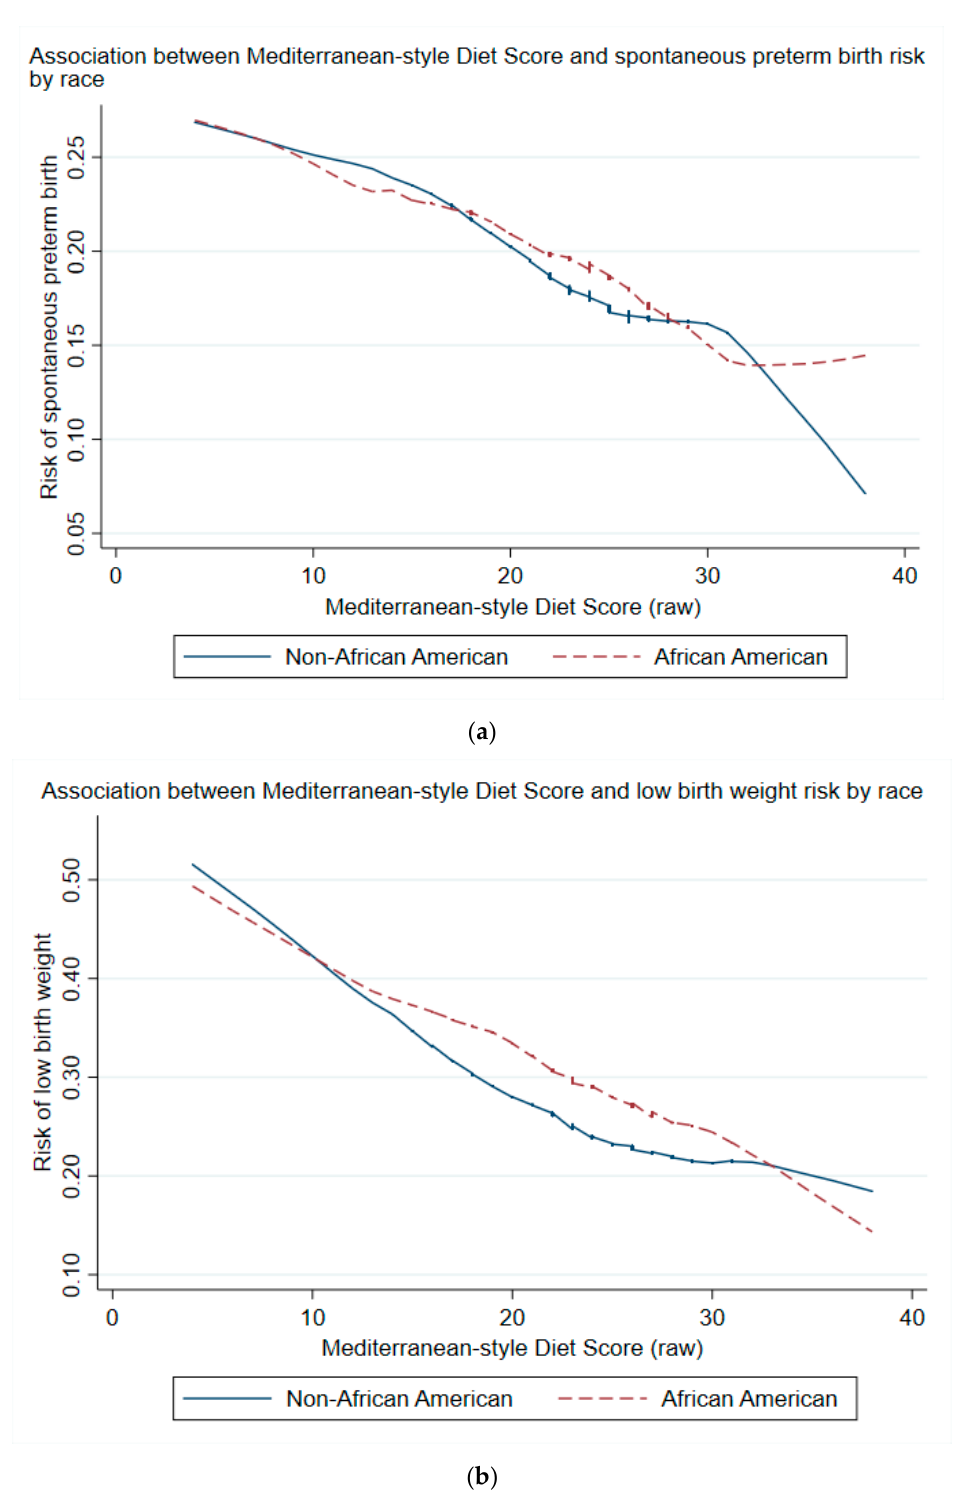
Figure 3. ( a ) Locally weighted scatterplot smoothing of spontaneous preterm birth outcome by MSDS (raw) stratified by race (blue curve for non-African American, red dashed curve for African American). Shown are smoothed curves provided by a weighted quadratic least squares regression over the respective relative risk values. No adjustments were made for this plot. X -axis represents the raw aggregate Mediterranean-style diet score. ( b ) Locally weighted scatterplot smoothing of low birth weight outcome by MSDS (raw) stratified by race (blue curve for non-African American, red dashed curve for African American). Shown are smoothed curves provided by a weighted quadratic least squares regression over the respective relative risk values. No adjustments were made for this plot. X -axis represents the raw aggregate Mediterranean-style diet